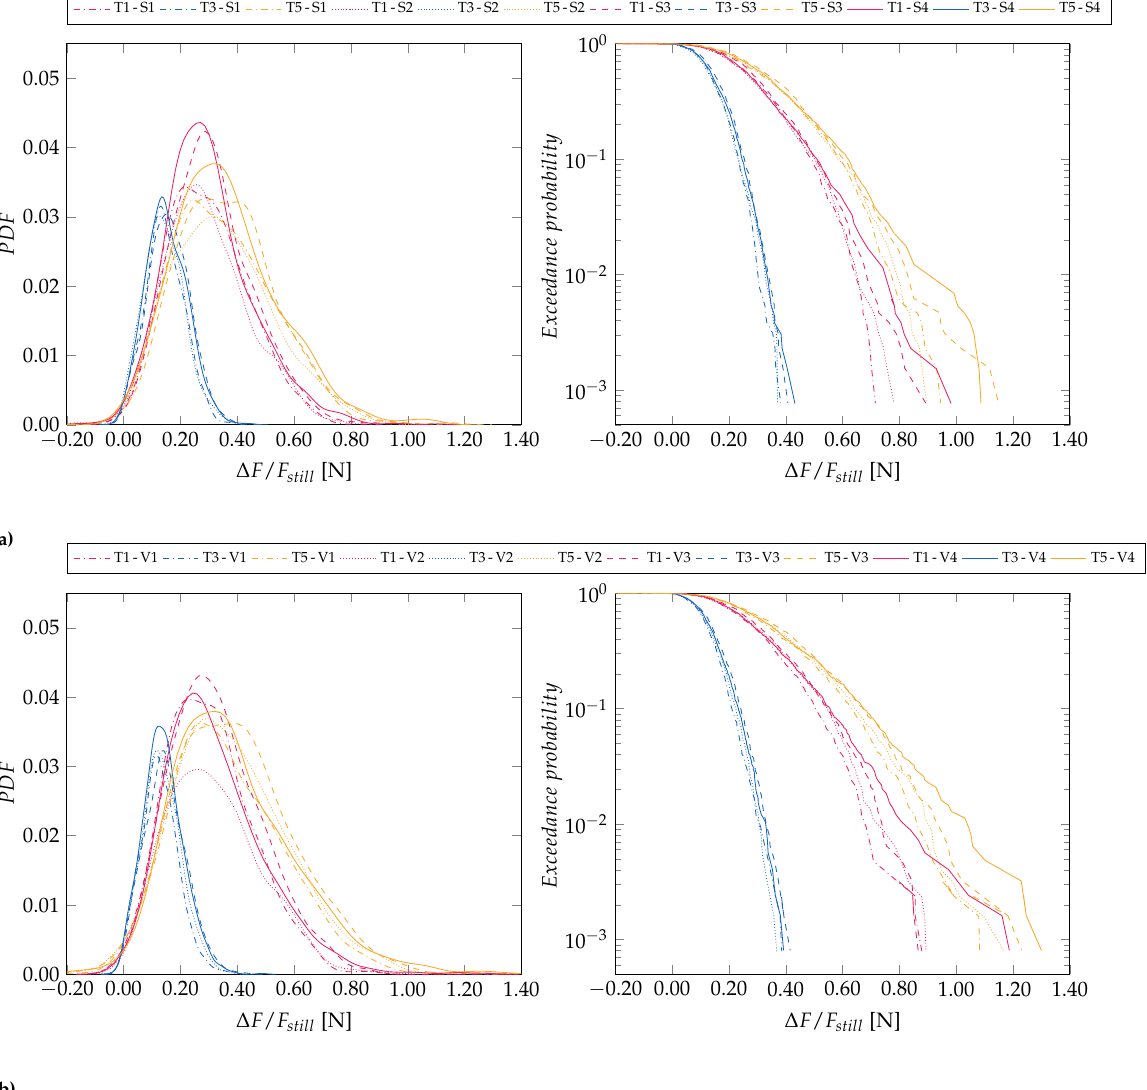
Figure 10. Probability density function (PDF) of the measured dimensionless force peaks for the four irregular wave tests S1-4 a and V1-4 b. The results for line T 1 (bow, or front tendon), T 3 (middle), and T 5 (aft, or back tendon) are charted with different colors. Extreme value analysis through the exceedance probability function for dimensionless force peaks for S1-4 a and V1-4 b. curves in the charts are grouped according to the tendon line they refer to, whereas 454 different line patterns correspond to the sea state realizations. In general, the distributions 455 of the force when analyzed for each sea state show to be quite consistent for the different 456 realizations; furthermore, they all are unimodal. Line T 1 (front tendon) and T 5 (back 457 tendon) have close expected values, with similar modes around 0.35 ∆ F / F still , which, 458 however, see remarkable differences accounting for the sea-state realization. Line T 3 459 (middle line) experiences a pattern of force that is much more consistent than the external 460